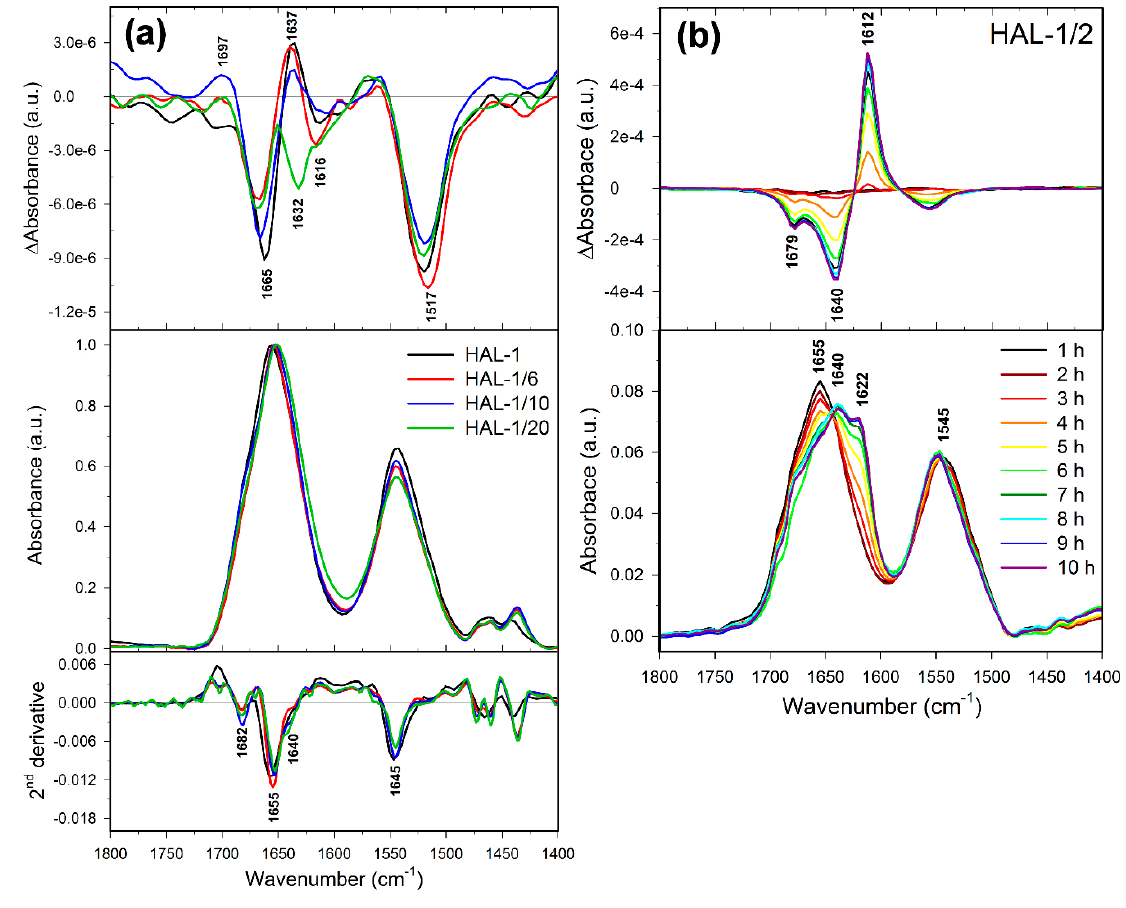
Figure 10. ( a ) VCD ( top )/IR ( middle )/second derivatives of IR spectra ( bottom ) of HAL-1, HAL-1/6, HAL-1/10, and HAL-1/20 in aqueous solution for samples in the 100 mg/mL concentration; ( b ) time dependence (1–10 h after preparation) of VCD ( top ) and IR spectra ( bottom ) of HAL-1/2 in aqueous solution for the sample in the 100 mg/mL concentration.